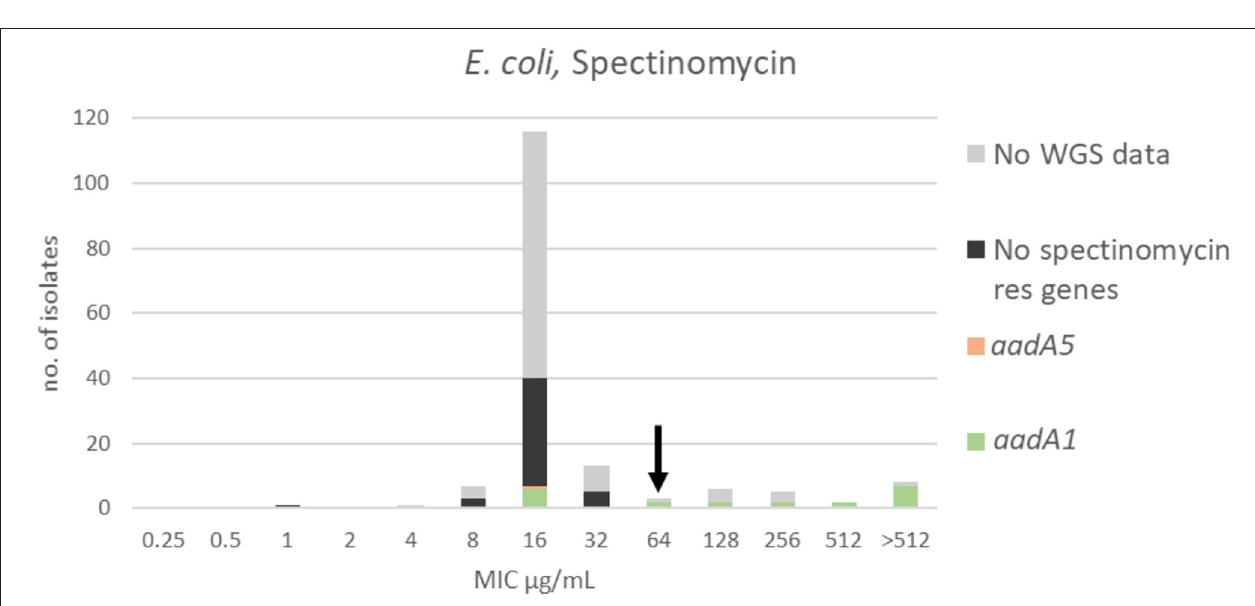
FIGURE 3 | MIC distribution of E. coli ( n = 162) against doxycycline in the test range of 0.06–128 µ g/mL. The arrow indicates the epidemiological cut-off value (ECOFF, EUCAST). Colors indicate if the isolates have been sequenced and whether they harbor known relevant resistance genes. WGS, whole-genome sequencing; res, resistance.